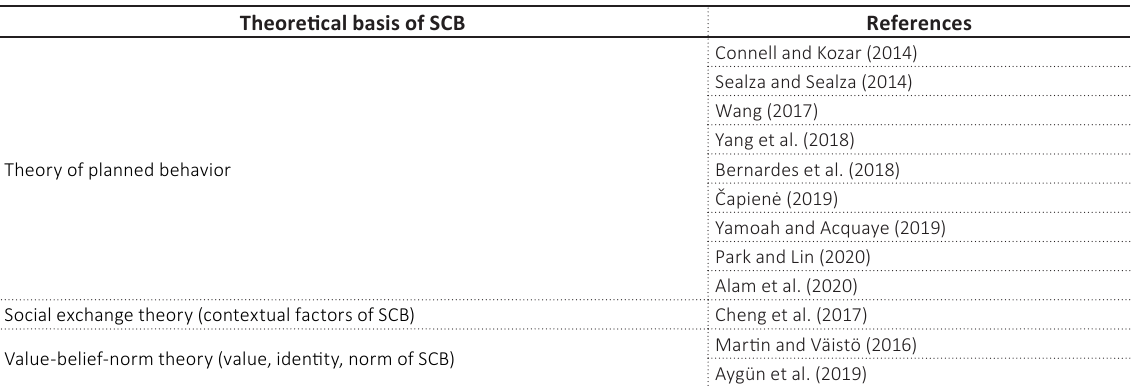
Table 1. Theoretical basis of sustainable consumption behavior in